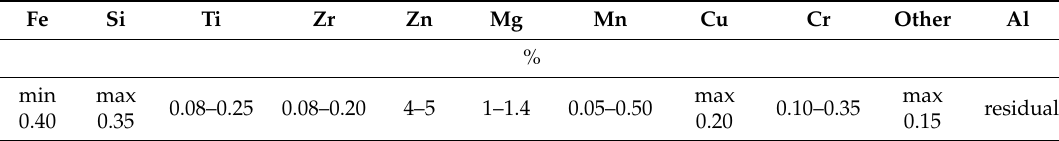
Table 1. Chemical composition of the EN AW 7020 alloy sheet metal of g = 12 mm, certificate no.: